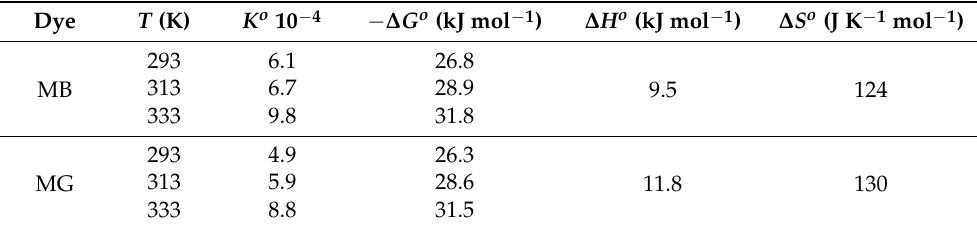
Table 5. Thermodynamic parameters of adsorption of the cationic dyes on